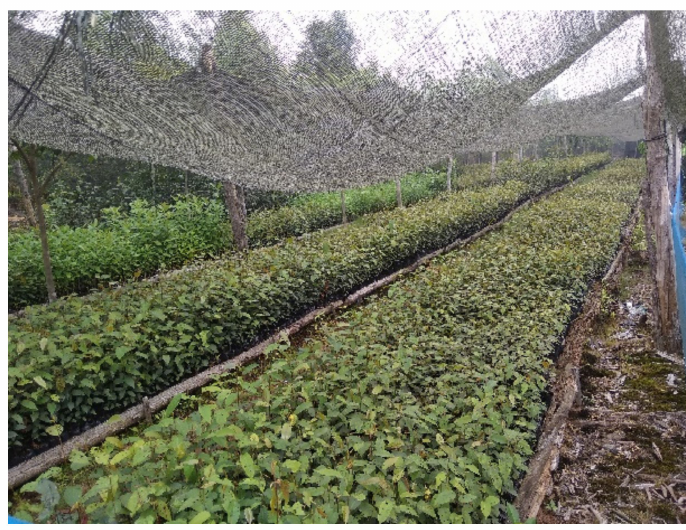
Figure 5. Seedling nursery in Tumbang